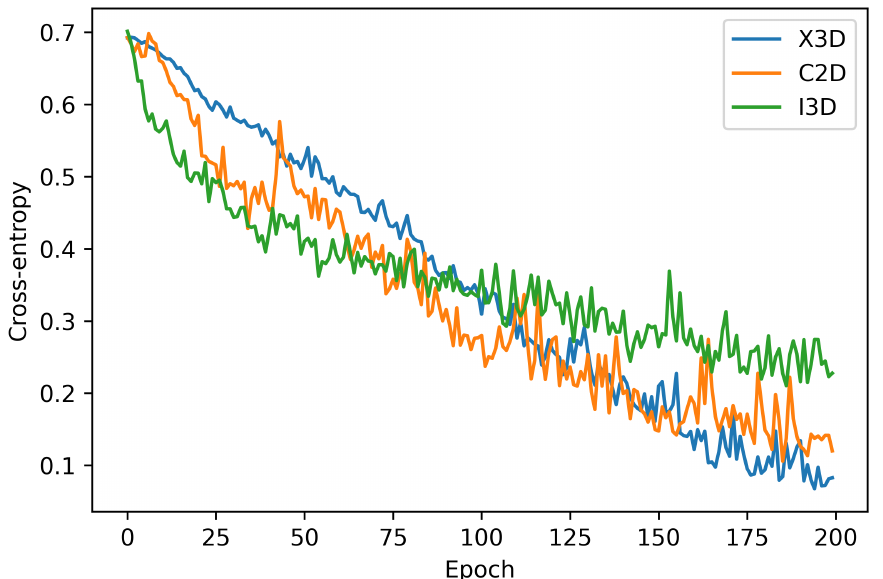
Figure 1. Visualizing the model convergence by computing the training loss for each epoch. The x -axis represents the epoch and the y -axis represents the respective cross-entropy training loss.